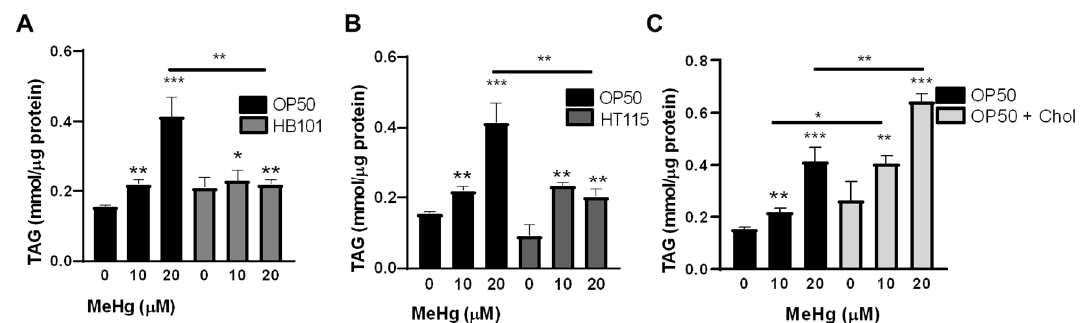
Figure 3. MeHg increases triglyceride content in worms fed a high-fat, but not low-fat, diet. Total triglycerides were measured in lysates from N2 worms fed OP50 or ( A ) HB101, ( B ) HT115, or ( C ) OP50 supplemented with cholesterol 48 h after MeHg treatment. Data are expressed as mean triglycerides mmol/ µ g protein ± SEM. All data are representative of five independent experiments. * p < 0.05, ** p < 0.01, *** p < 0.001 as compared to untreated, OP50-fed control. Horizontal bars represent comparisons between Hg-treated worms fed different